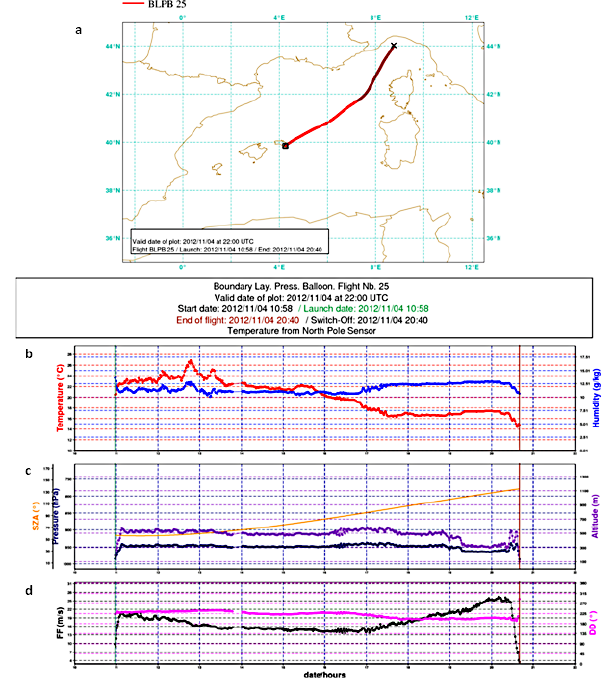
Figure 22. (a) PBL balloon (#25) track. Measurement time series along the balloon track launched on 4 November 2012 at 10:58UTC from the Balearic Islands ending at 20:40UTC in the Genoa Gulf; (b) temperature (red line) and relative humidity (blue line); (c) pressure (dark blue) and altitude (purple line); (d) wind intensity (black line) and direction (pink line). Courtesy of Alex Doeren- becher (CNRM-France).